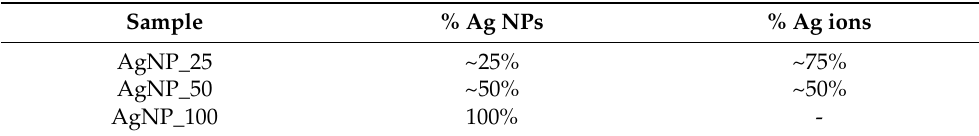
Table 1. Silver content allocation.